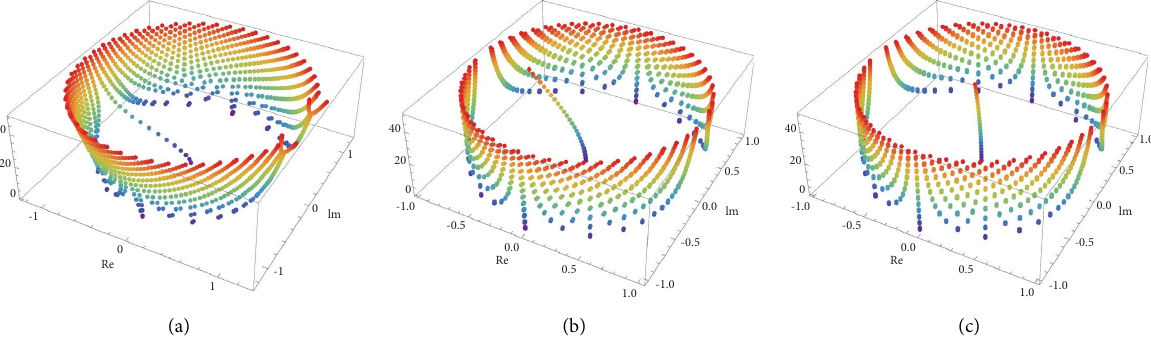
Figure 2: Locations of D ( x ) for 0 ≤ n ≤ 50: (a) q � 0 . 01, (b) q � 0 . 001, and (c) q � 0 . 0001. n,q